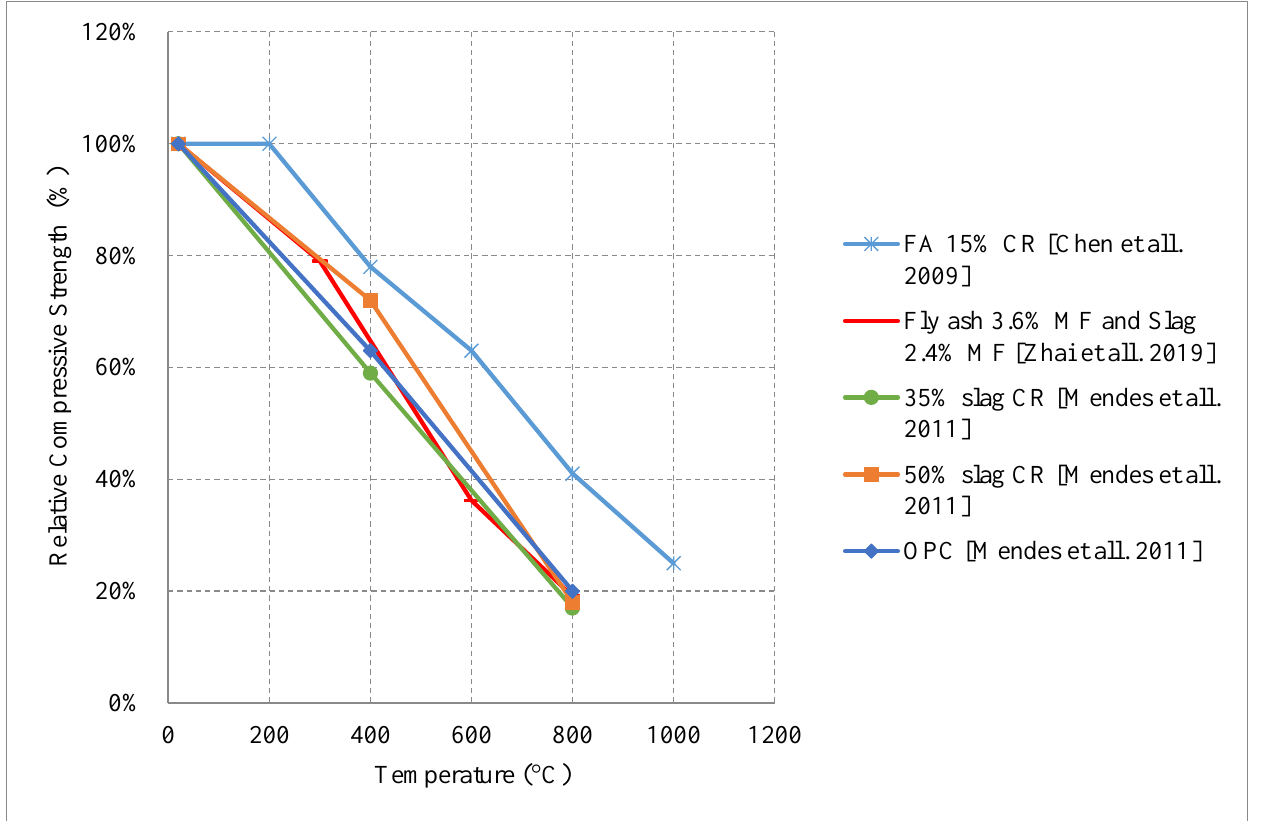
Figure 7. Effect of different constituents on the relative compressive strength of water cooled NSC. CR: Cement Replacement, MF: Mass Fraction [36,37,45].